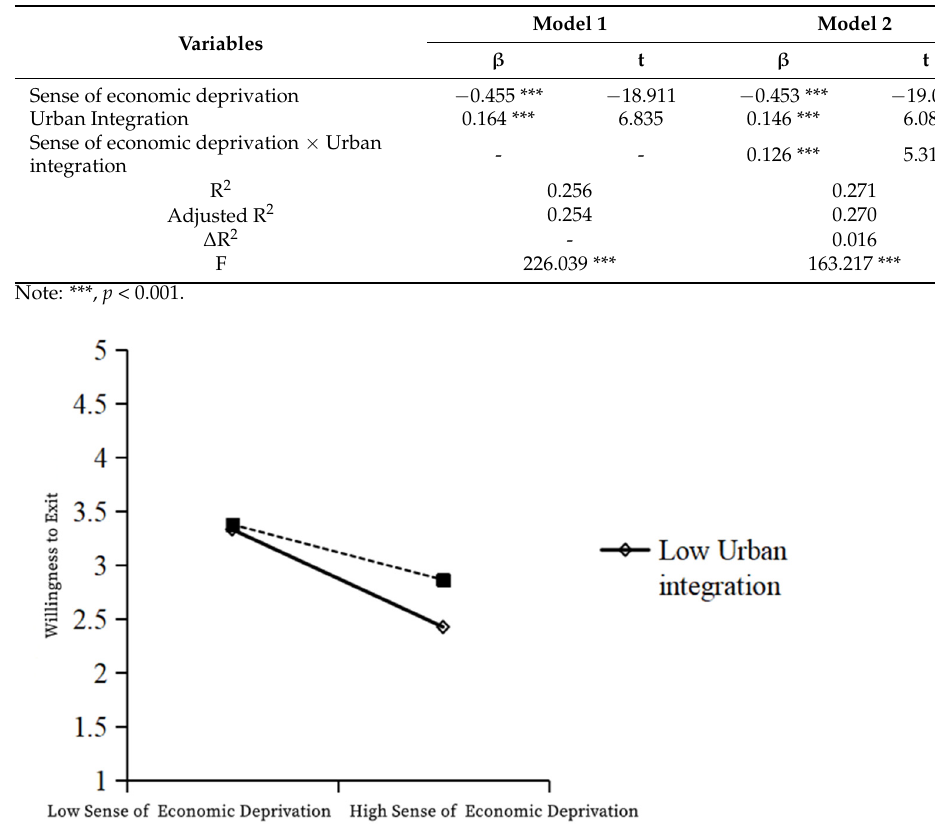
Figure 4. Moderating effect of urban integration between the sense of economic deprivation and willingness to withdraw.